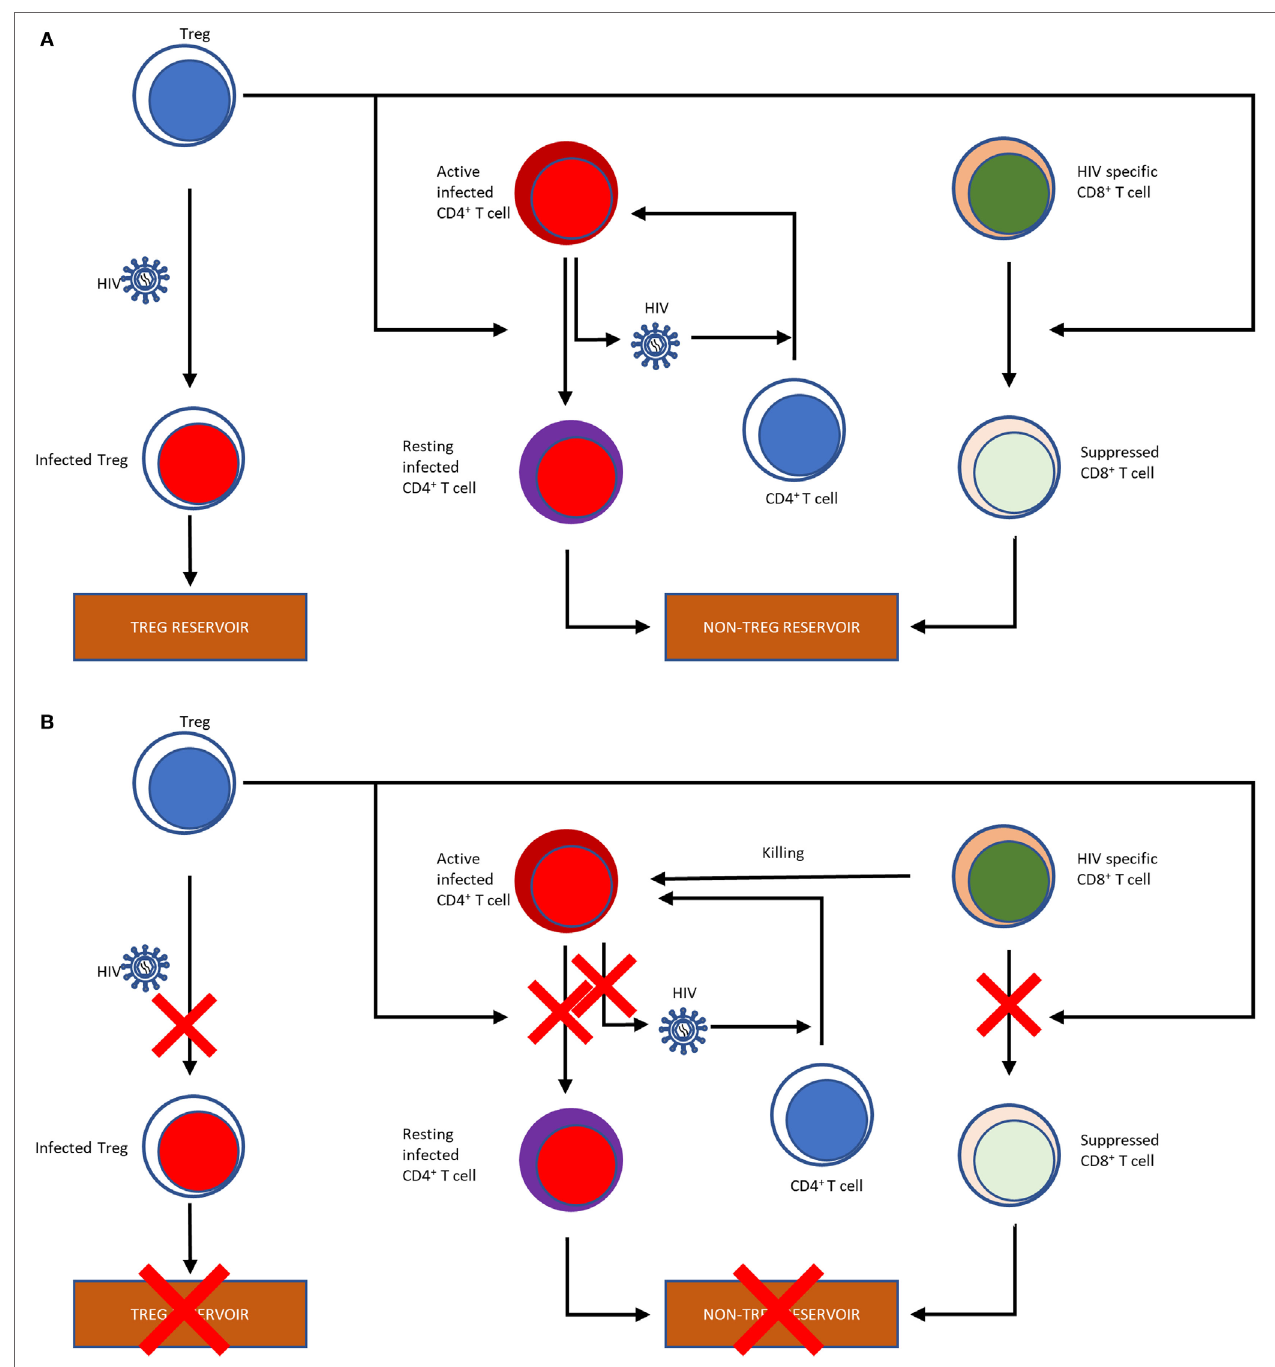
FigURe 1 | Flow chart illustrating the effects of Tregs on the HIV reservoir (A). Tregs can be infected with HIV, thereby contributing to the HIV reservoir. Tregs reverse the activation status of the HIV-infected T cells into resting T cells, further contributing to the reservoir formation. Finally, by suppressing the HIV-specific CD8 + T cells, which would otherwise kill infected cells, Tregs also shape the non-Treg reservoir. Potential effects of Treg depletion on the HIV reservoir (b) . Treg depletion obviously result in a reduction of the Treg reservoir through direct killing. Treg depletion also abolish their suppressive effects of the T cells, which may reverse their resting status, become activated and produce and release the virus. Finally, reversion of the suppressive effect of Tregs on HIV-specific CD8 + T cells has the potential to boost their anti-SIV activity, which can also curtail the